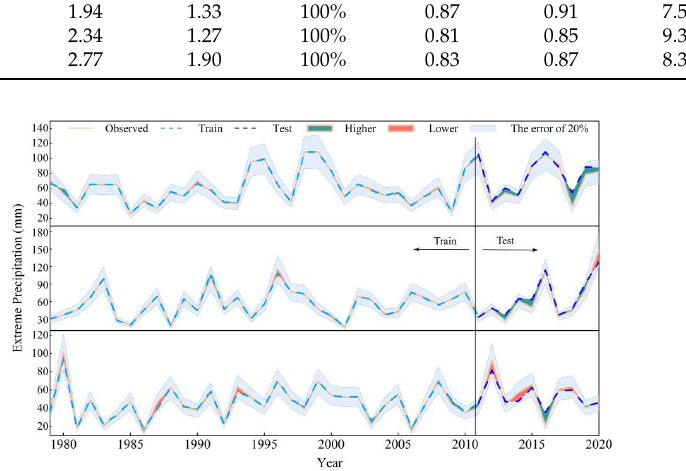
Figure 4. Prediction performance results of the proposed method during training and testing.